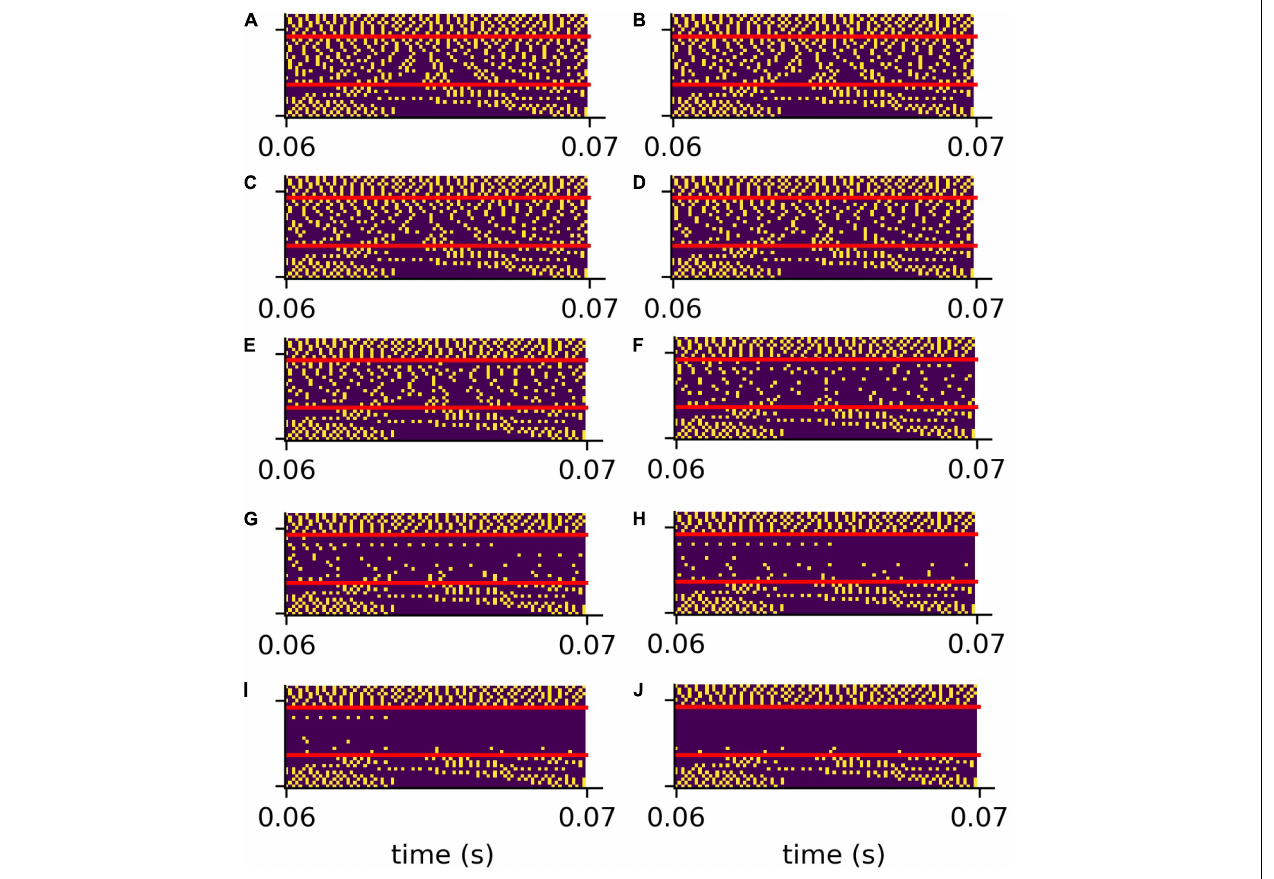
FIGURE 5 | Compressed spike patterns with added hearing loss. The figure shows the down-sampled spike patterns of the same word as shown in Figure 4 . The speech relevant frequency range (400 Hz–4 kHz) is artificially weakened (hearing loss). Panles (A–J) refer to hearing losses 0–45 dB.